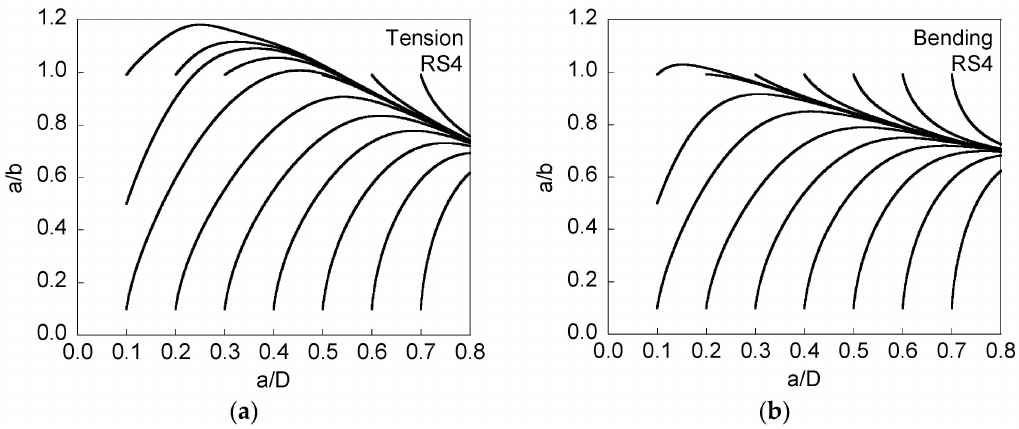
Figure 7. Evolution of the aspect ratio a / b with crack growth (represented by the relative crack depth a / D ) for RS4, cyclic tension loading ( a ); and cyclic bending moment ( b